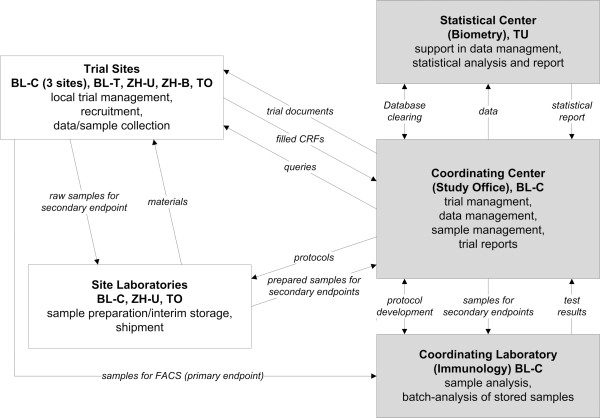
Multicenter structure and trial management. Legend: Scheme of the trial workflow. BL-C = Berlin-Charité, BL-T = Berlin-Trauma-Hospital; TU = Biometry Tübingen; ZH-U = Zurich-University Hospital; ZH-B = Zurich-Balgrist; TO = University Hospital Toronto.